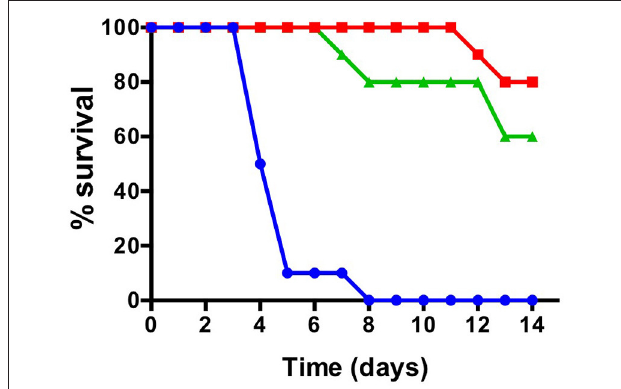
FIGURE 4 | Intramuscular experimental challenge. Rainbow trout survival following intramuscular injection with F. psychrophilum strains THCO2-90 (blue), gldG::Tn (red), and gldD::Tn (green). The plots show the survival of rainbow trout following intramuscular challenge with 2 × 10 4 CFU of each strain for 14 days. The results are representative of two independent experiments.